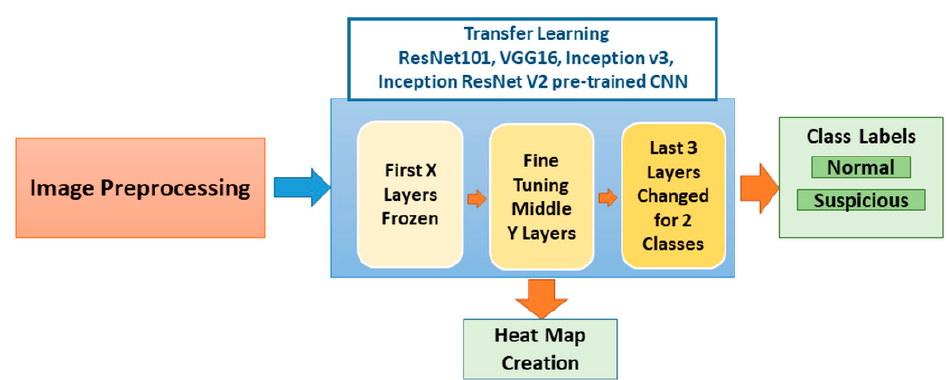
Figure 1. Block diagram of the system. The image preprocessing stage starts with patching the image and continues with the augmentation of the image patches. Pre-trained Inception-ResNet-v2 was retrained with these images. Classification and heat map generation were performed. Four pre-trained networks were independently used to analyze the results. Each network has a different number of layers (ResNet101 → 347-layer, VGG16 → 41, Inception v3 → 315-layer, and Inception ResNet v2 → 824-layer) with variation in frozen layers (ResNet101 → 79-layer, VGG16 → no frozen, Inception v3 → 307-layer, and Inception ResNet v2 → 818-layer) and fine-tuning of middle layer numbers; we represent them as X and Y in the figure). CNN: convolutional neural network.